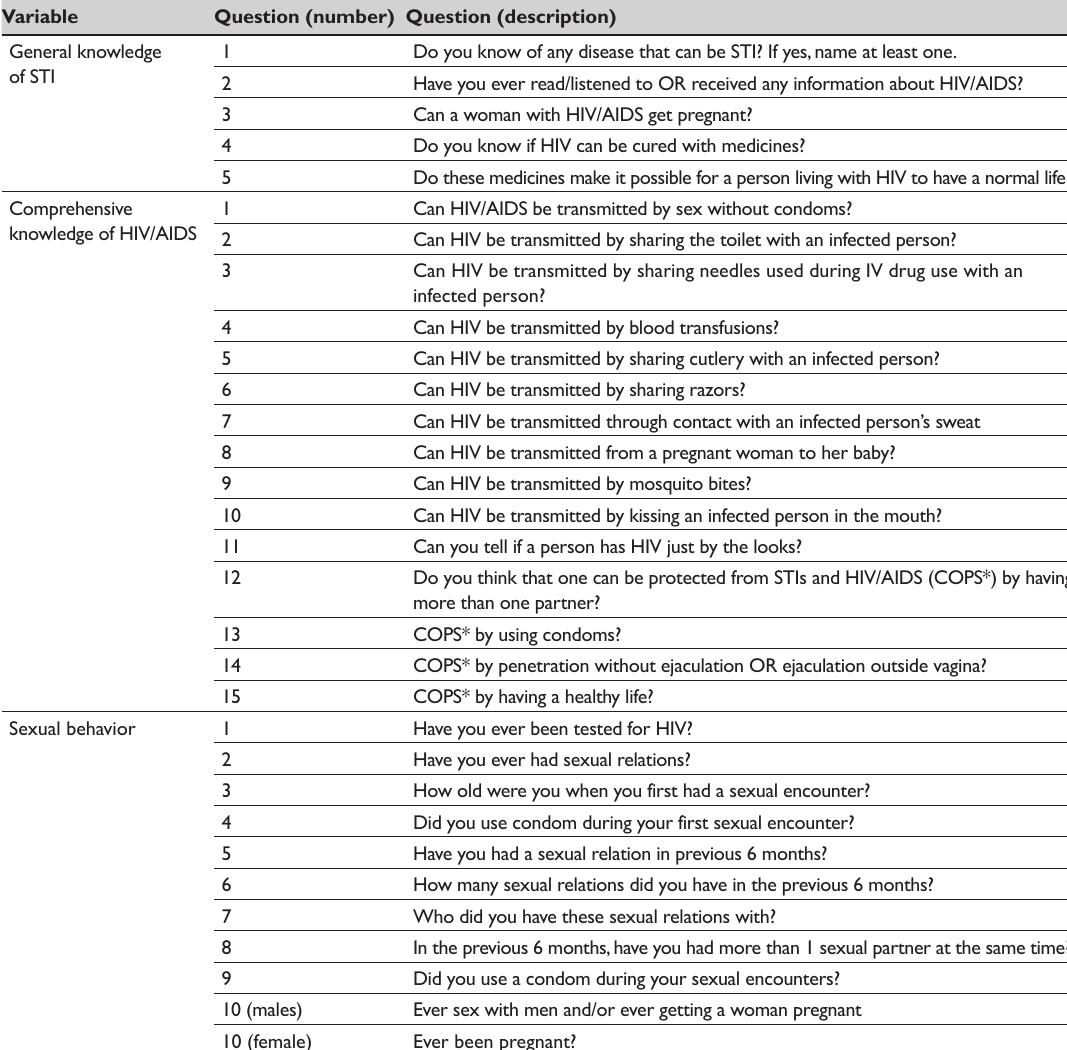
Table 1: Questions used to assess general knowledge of sexually transmitted infections (STIs), comprehensive knowledge of HIV/AIDS and sexual behavior (Study Questionnaire)